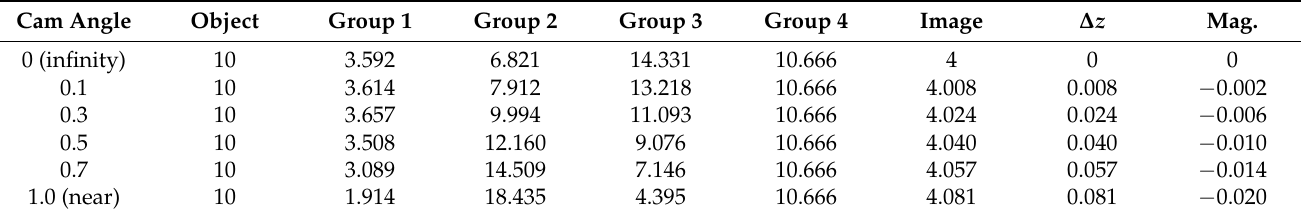
Table 3. Locus table for our designed final collimator